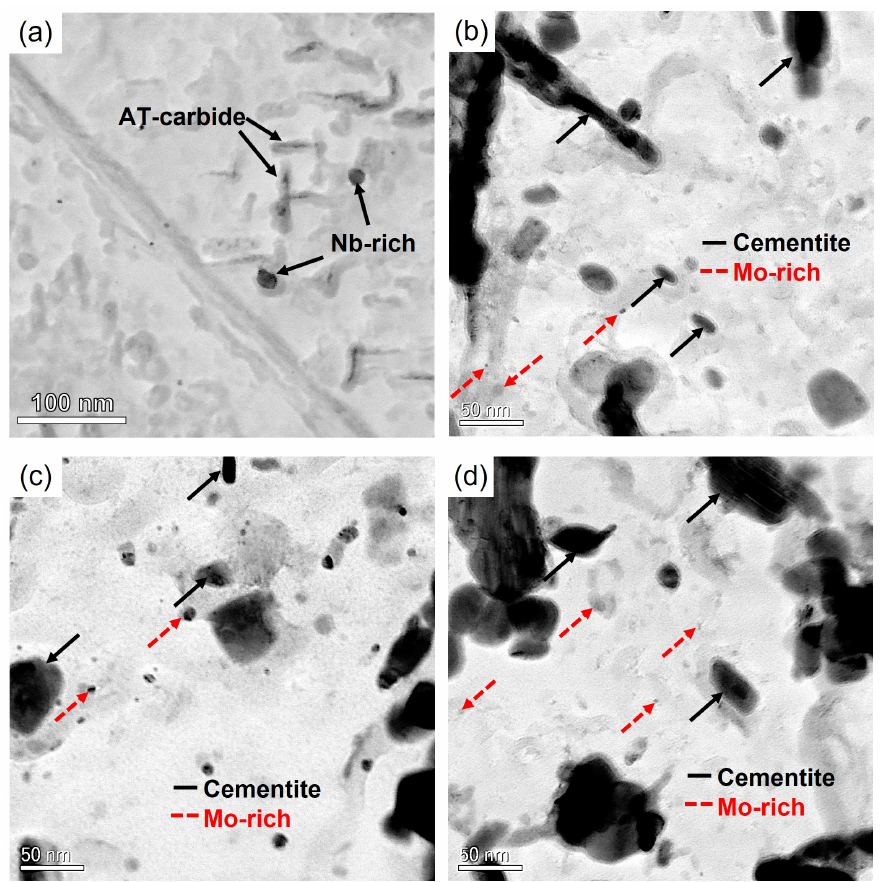
Figure 5. Results of three driving scenarios: no campaign, billboards, smart watch, for: ( a ) PncSL; Figure 6. Representative bright field images from the scanning transmission electron microscopy ( b ) PST; ( c ) AMS; and ( d ) AS. (STEM) and energy dispersive X-ray spectroscopy EDS analysis on carbon replicas of Material A. ( a ) AsQ and samples tempered at 600 ◦ C for ( b ) 0 h, ( c ) 1 h and ( d ) 24